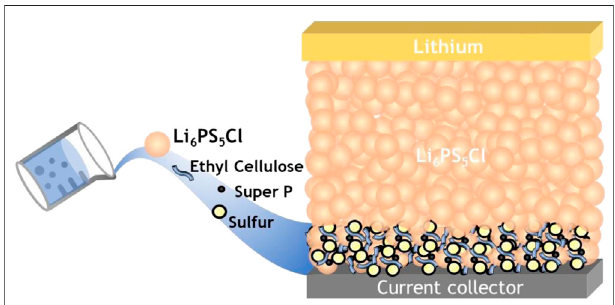
FIGURE 1 | Schematic diagram of the slurry Li 6 PS 5 Cl-coated sulfur- composite electrode and S/Li 6 PS 5 Cl/Li